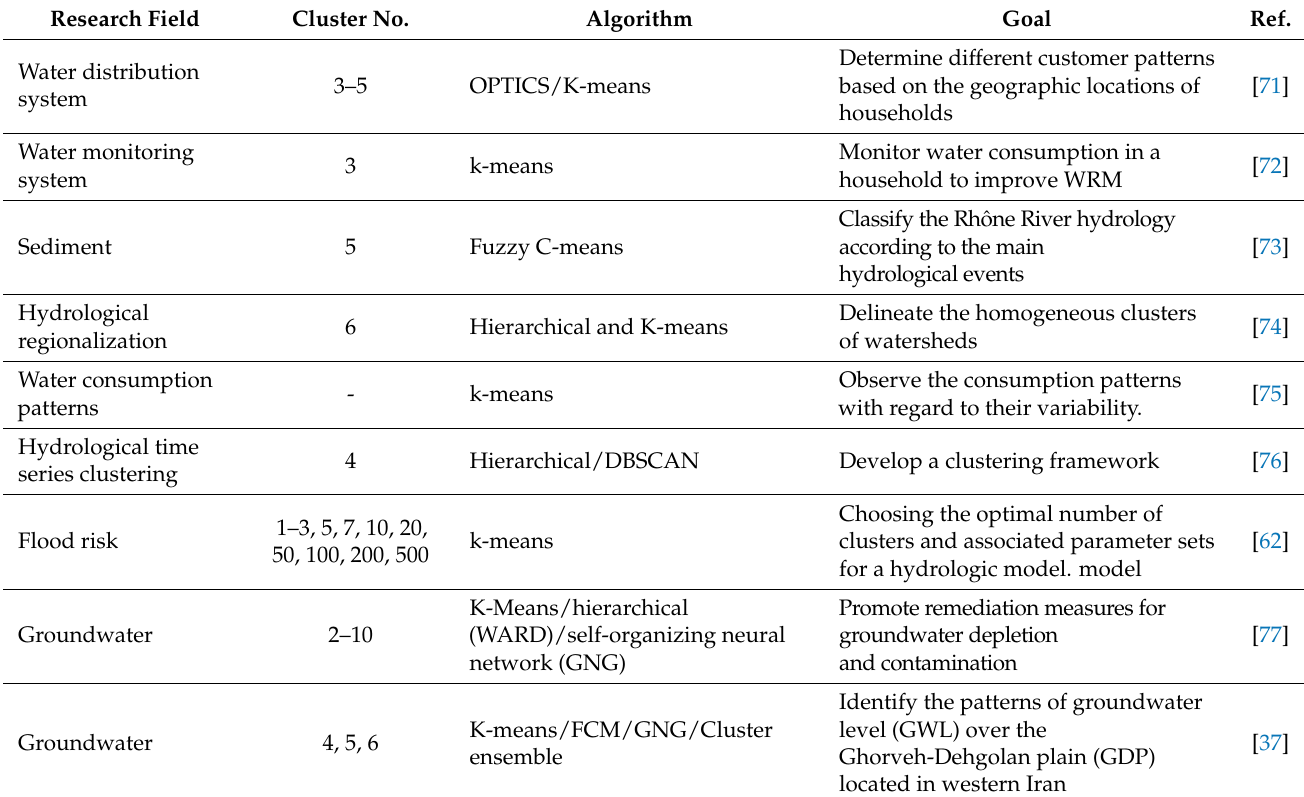
Table 6. Applications of clustering algorithms in